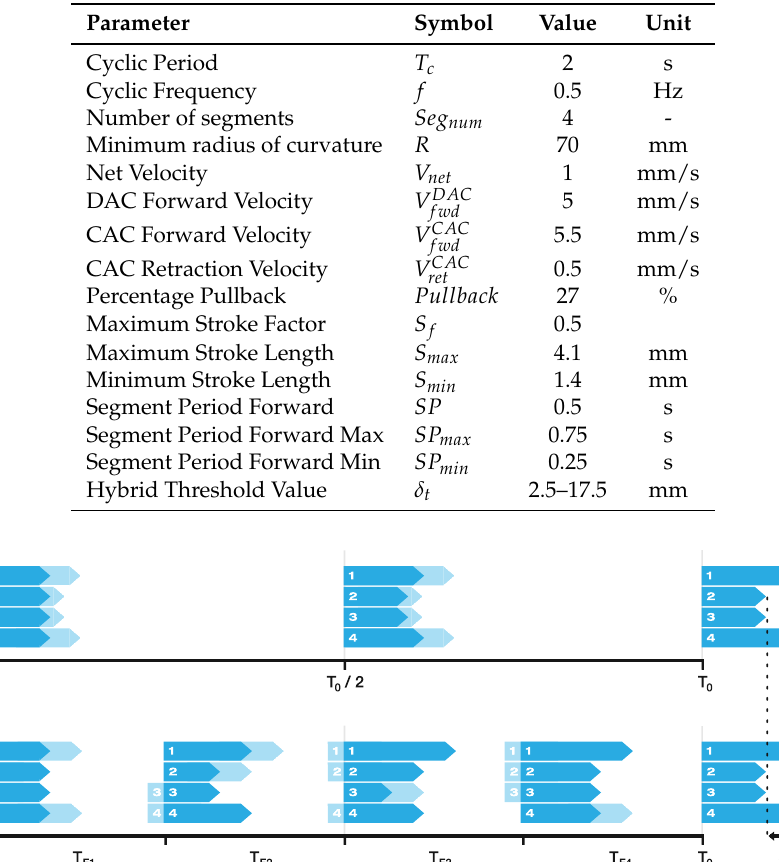
Table 1. Controller parameters.